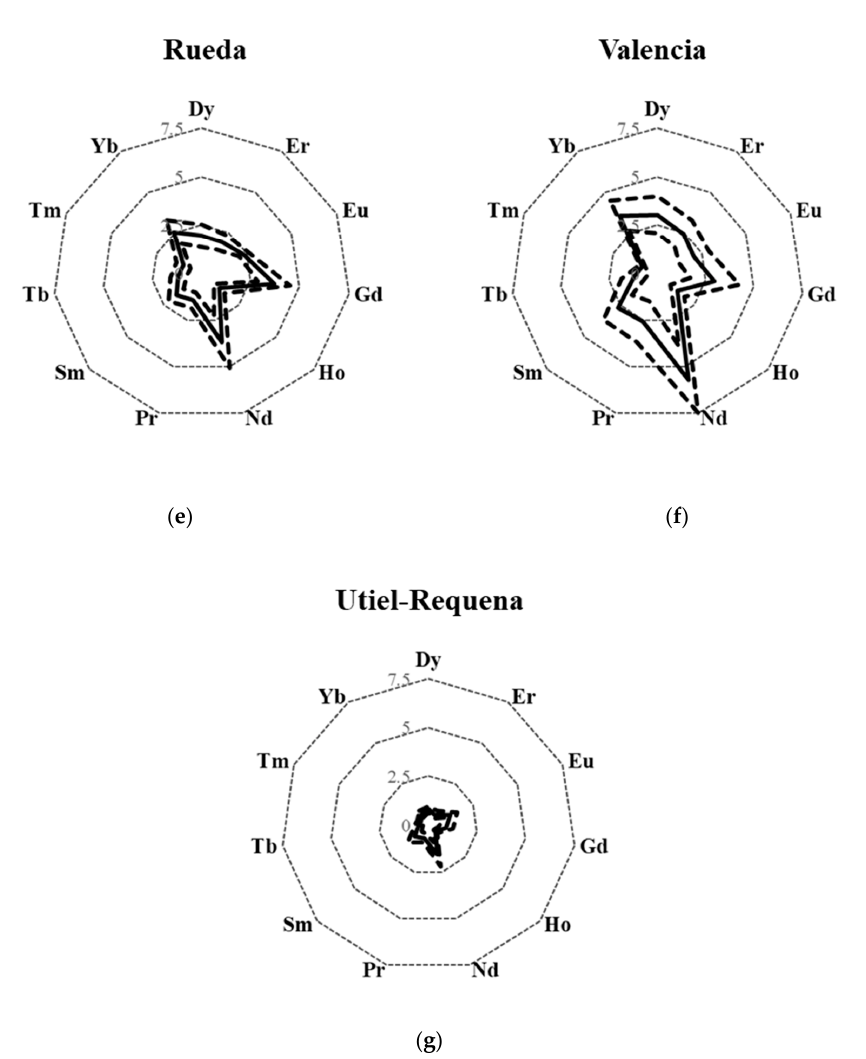
Figure 2. REEs (Dy, Er, Eu, Gd, Ho, Nd, Pr, Sm, Tb, Tm and Yb) fingerprint obtained for designation of origin. Continuous line: average; broken line: average ± standard deviation. Concentration units: µg kg − 1 . ( a ) Alicante; ( b ) Castilla la Mancha; ( c ) Ribera de Duero; ( d ) Rioja, ( e ) Rueda, ( f ) Valencia; and ( g